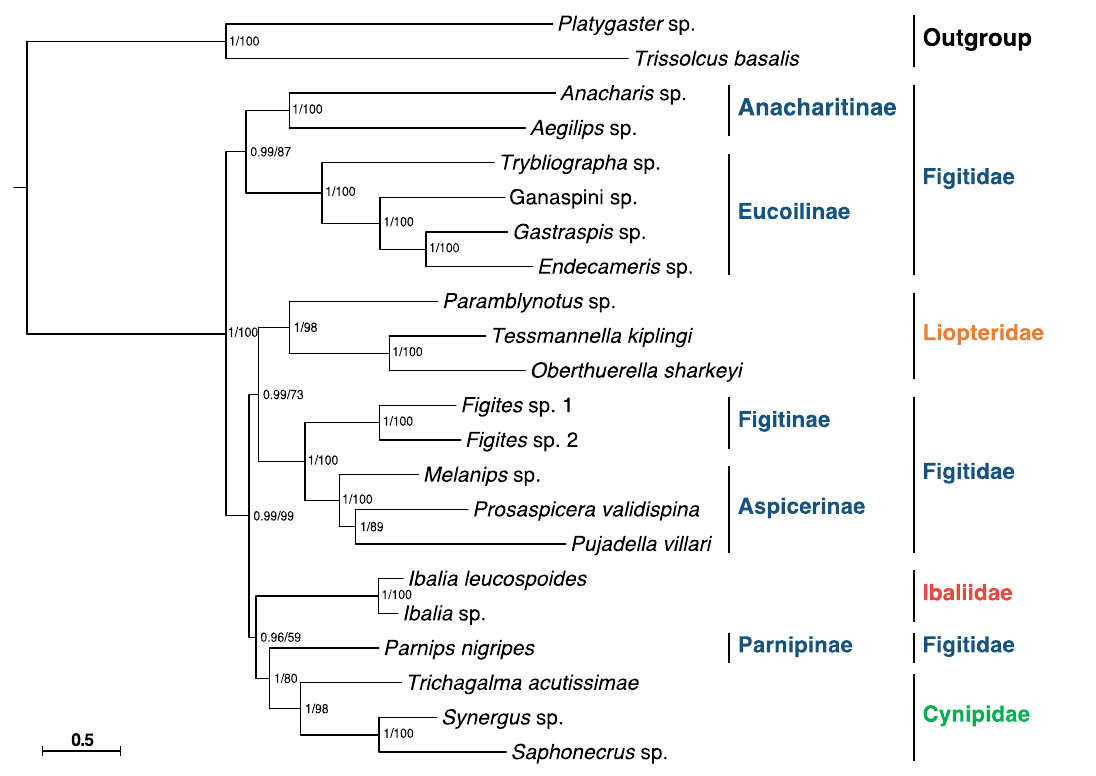
Table S4: Relative synonymous codon usage in 16 Cynipoidea mitogenomes; Table S5: Synonymous and nonsynonymous substitutional analysis of 13 protein coding